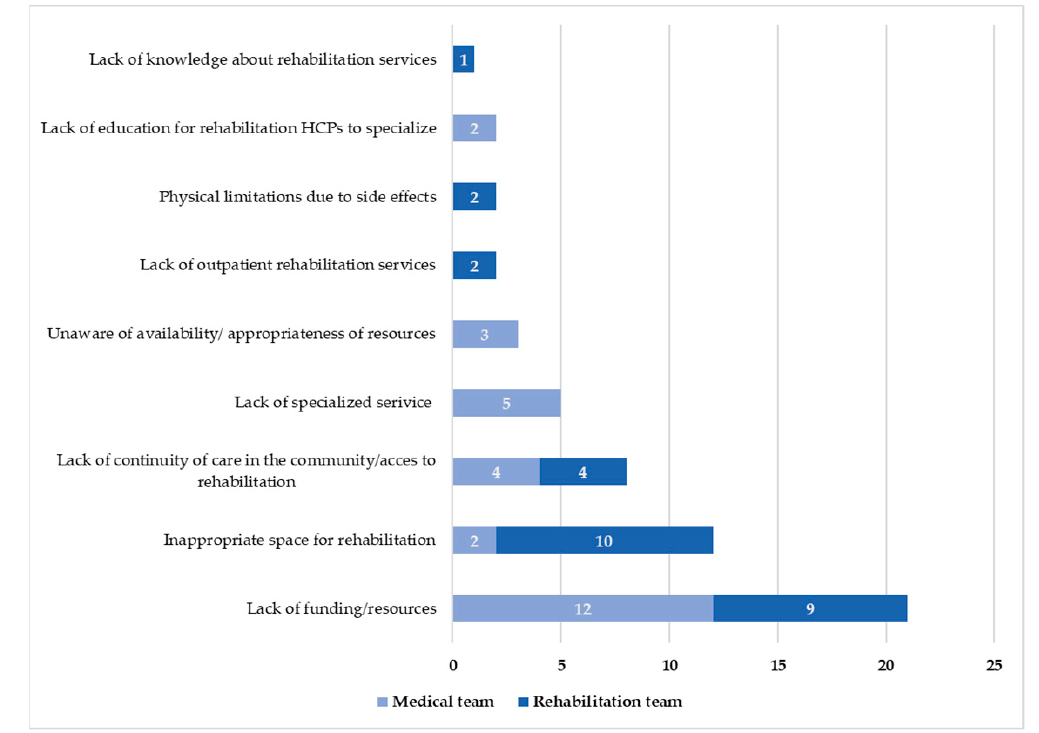
Figure 2. Frequency of reported barriers to rehabilitation programs reported by the medical and rehabilitation teams.